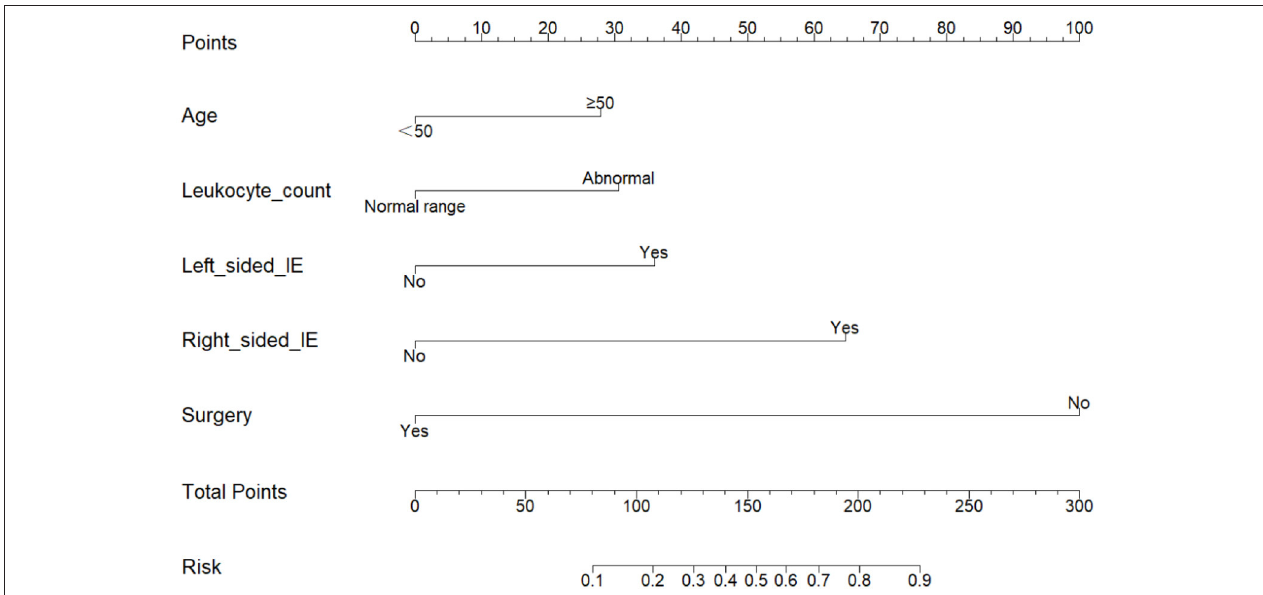
FIGURE 2 | Nomogram for predicting in-hospital mortality in patients with infective endocarditis. To estimate in-hospital mortality in patients with IE, mark patient values at each axis, draw a straight line perpendicular to the point axis, and sum the points for all variables. Next, mark the sum on the total point axis and draw a straight line perpendicular to the risk axis.